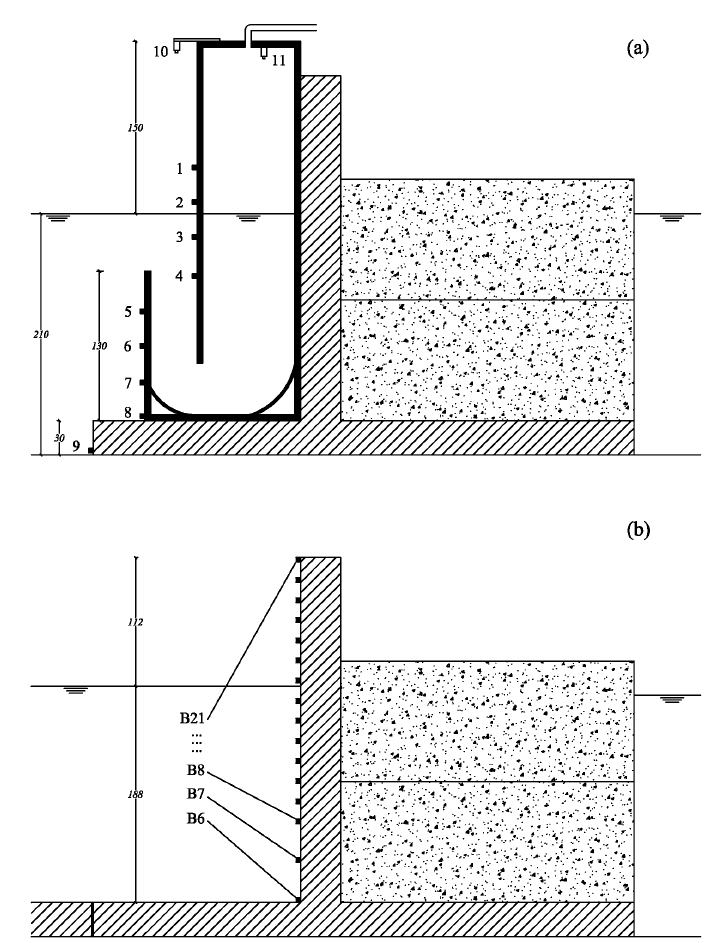
Figure 2. ( a ) Cross section of the central caisson of the small scale model of U-OWC equipped by gauges (1–9 pressure transducers; 10–11 ultrasonic probes). ( b ) Cross section of the central caisson of the small scale model of upright breakwater equipped by gauges (from [14]). Measures are in